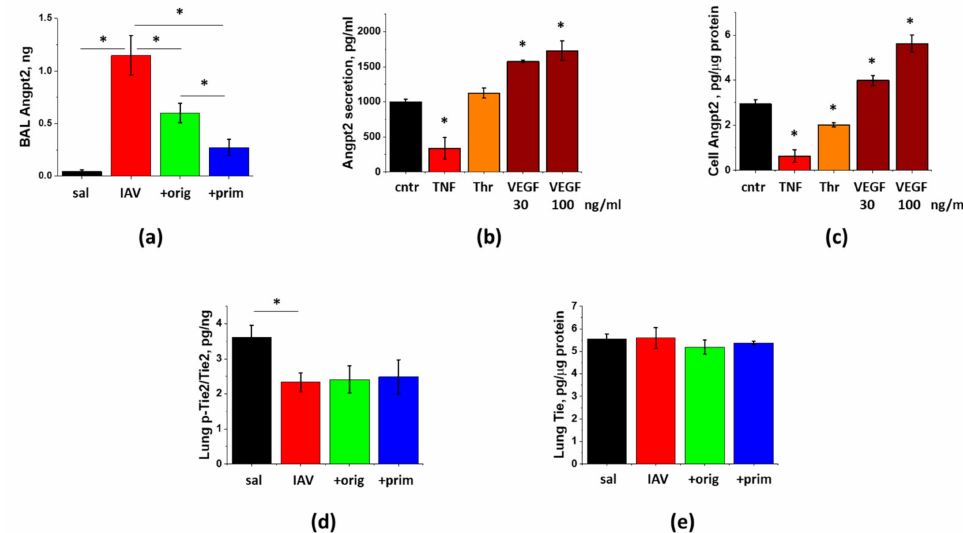
Figure 7. Lung injury is associated with the release of Angpt2, which can be decreased by ASC-CS. Mice from Figure 6 (saline to lung- black; IAV + PBS—red; IAV + original ASC-CS—green; IAV + primed ASC-CS—blue) were terminated at Day9 to analyze for BAL Angpt2 ( a ) and lung p-Tie2 ( d ) and Tie2 ( e ) levels. n = 4–6 per group, presented are mean +/ − SEM. * for p < 0.05 by t -test with Welch correction (unequal variances) between groups indicated. HPAEC were stimulated with 20 ng/mL TNF α , 2 unit/mL Thrombin, and 30 and 100 ng/mL VEGF ( b , c ). After 24 h, media ( b ) and cell extracts ( c ) were collected and analyzed. Levels of Angpt2 were normalized per protein levels in cell extracts. Mean +/ − SEM from 3 independent experiments are presented. * for p < 0.05 by t -test with Welch correction (unequal variances) when compared with